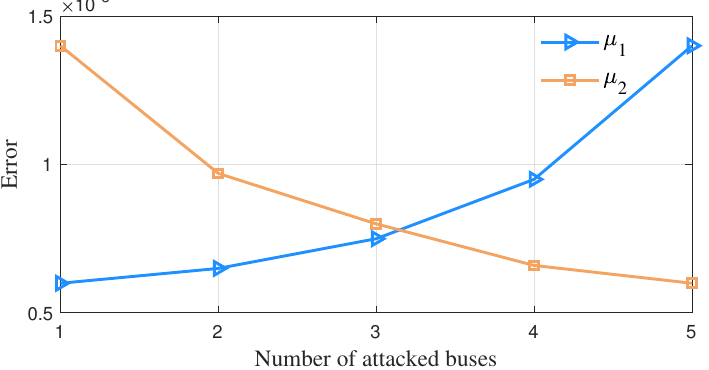
Figure 9. The error variation of the parameter µ while the number of attacked buses varies.